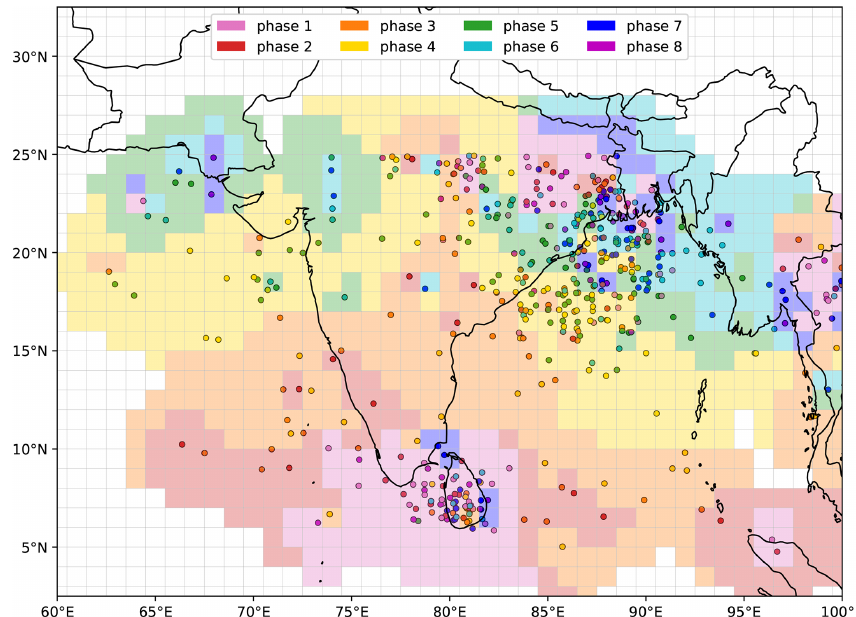
Figure 4. The effect of the BSISO on monsoon LPS genesis. LPS genesis points (June–September 1979–2018) are coloured according to the phase of the BSISO in which they occurred. The background field estimates these values over a 1 ◦ grid by averaging all points using an inverse-square distance weighting. Grid squares are not coloured if there is no LPS genesis within 300km during the analysis period. Genesis points occurring when the amplitude of the BSISO is less than one – about 41% of the total sample – are not